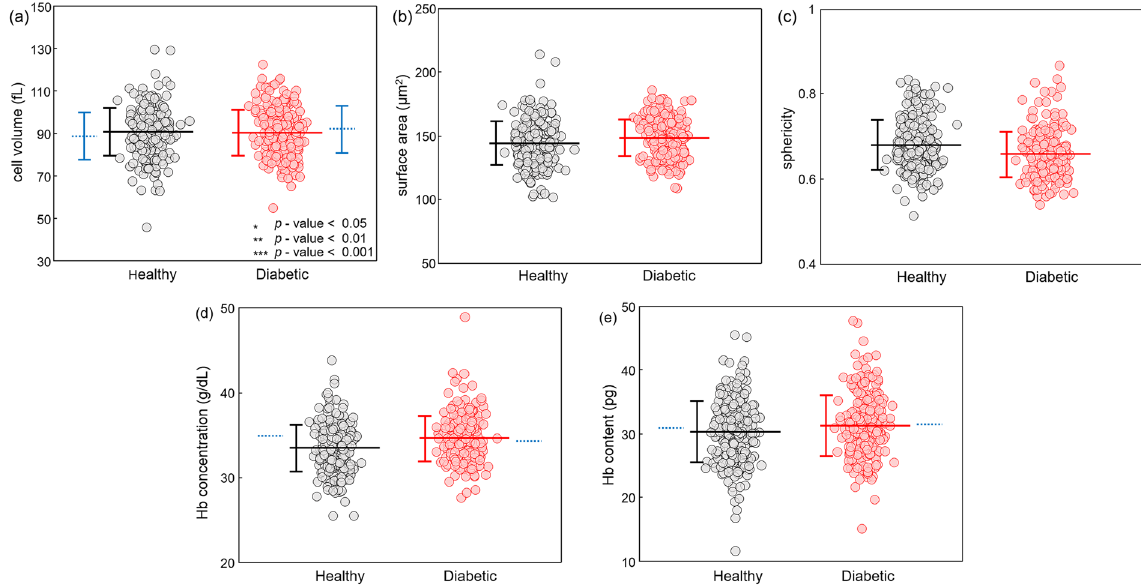
Figure 2. Morphological and biochemical parameters for all measured RBCs from healthy controls and diabetic patients: ( a ) volume, ( b ) surface area, ( c ) sphericity, ( d ) cytoplasmic Hb concentration and ( e ) Hb content. Each circle denotes an individual RBC measurement. The horizontal lines and the error bars represent the calculated mean value and sample standard deviation, respectively. The blue dotted lines correspond to results from complete blood count